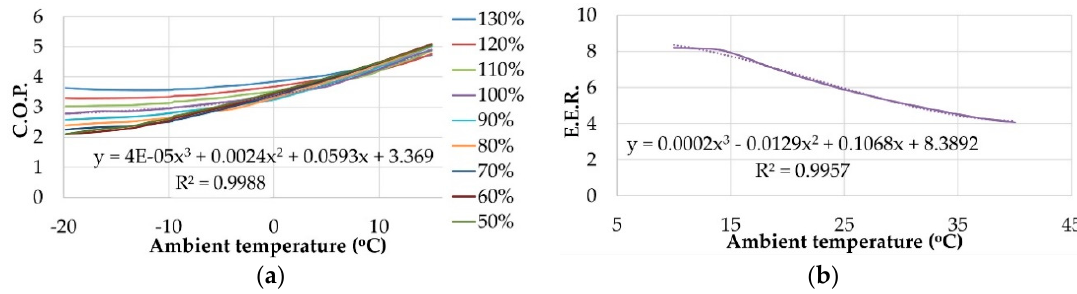
Figure 8. ( a ) Typical coefficient of performance (COP) curves for a commercial, air-to-air variable refrigerant volume (VRV) heat pump model. ( b ) Typical energy efficiency ratio (EER) curves for a commercial, air-to-air VRV heat pump model.